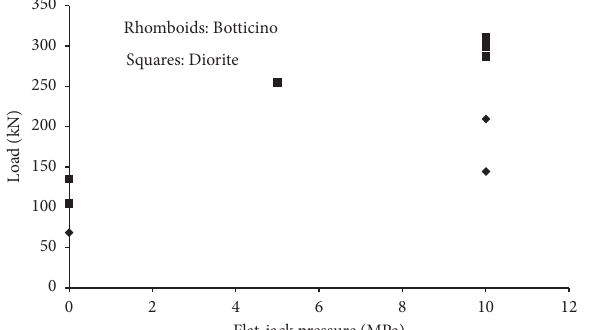
Figure 18: Maximum thrust load versus flat-jack confinement pressure for Botticino (rhomboids) and Diorite (squares) under the given settings [27].